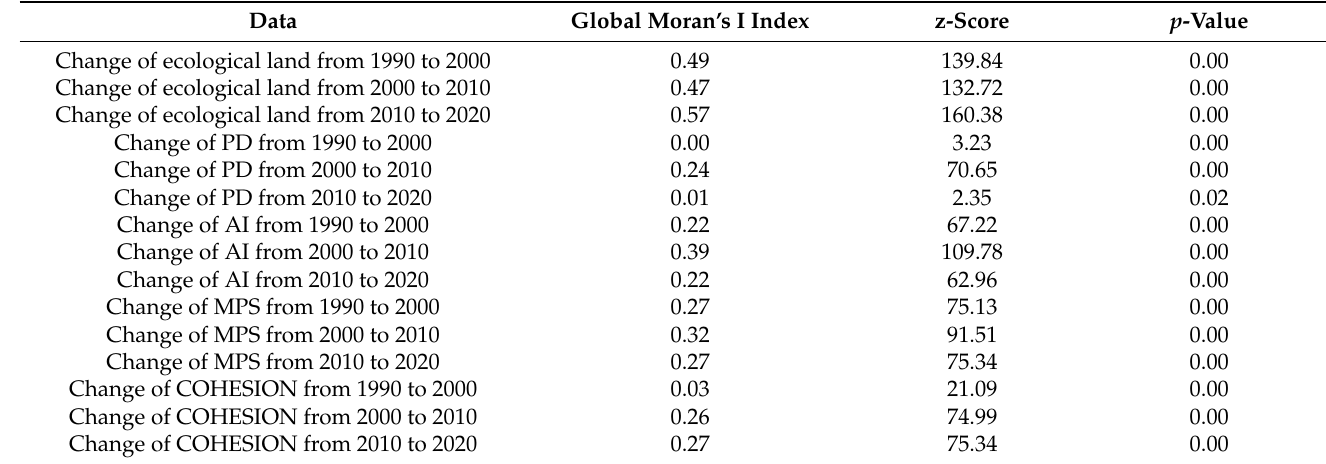
Table A2. Global Moran’s I index values of various change